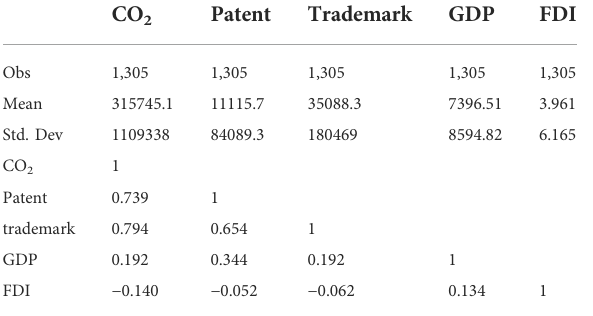
TABLE 3 Descriptive statistics and correlation matrix of the BRI countries.